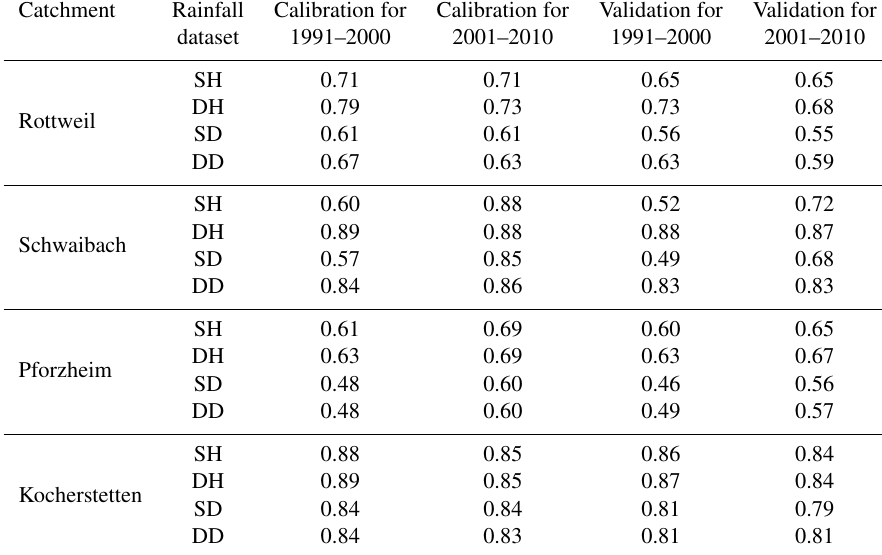
Table 3. Average NS model performance for the lumped HBV model. Catchment